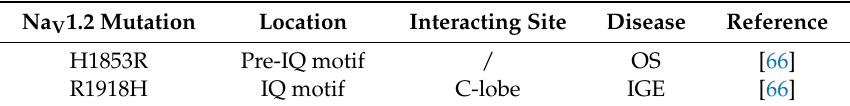
Table 3. Mutations in Na V 1.2 channels influencing CaM binding. OS: Ohtahara syndrome; IGE: idiopathic generalized epilepsy.